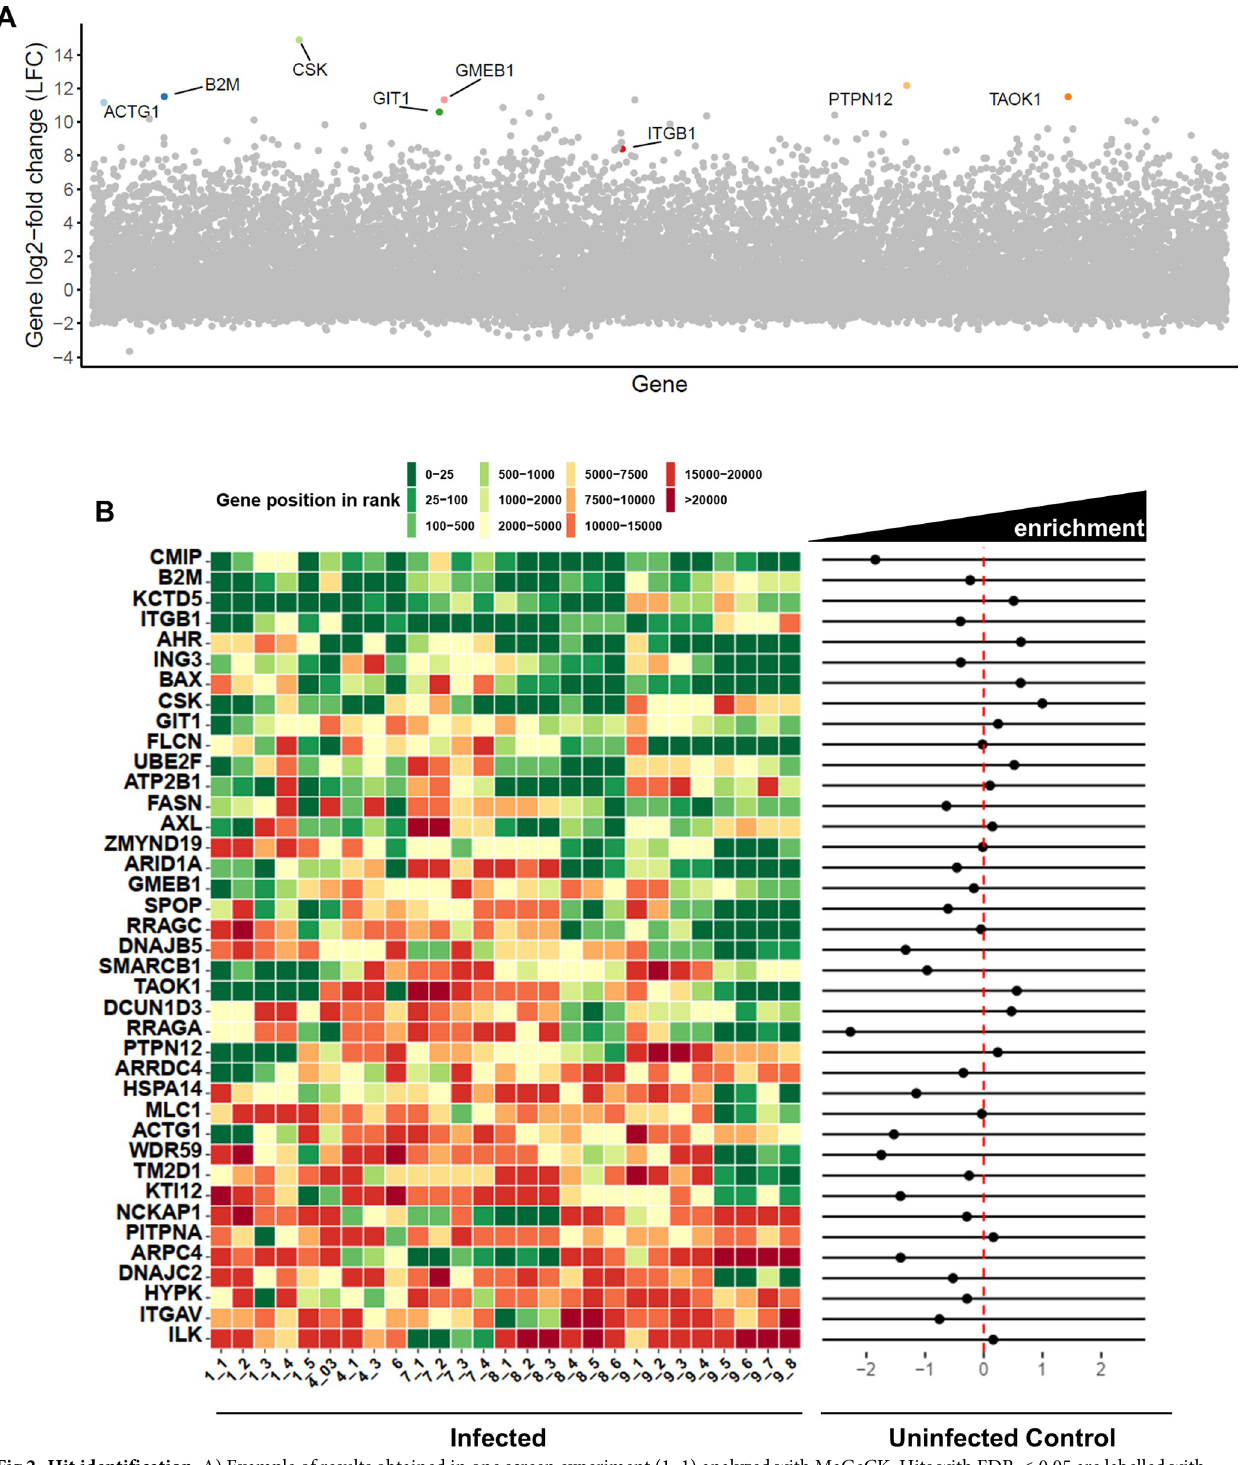
Fig 2. Hit identification. A) Example of results obtained in one screen experiment (1_1) analyzed with MaGeCK. Hits with FDR < 0.05 are labelled with gene name tags. B) Heatmap summarizing the 27 experiments/experiment variations. Experiments are named with the starting cell pool followed by a number for the conditions used for that particular sample (see S1 Table). Genes with FDR < 0.05 in at least 1 experiment are included in the analysis. Enrichment results after selection are shown in the left panel as a heatmap representing the gene rank obtained with MaGeCK. For comparison, the right panel shows the log2-fold change for each gene in non-infected control experiment. Dots to the right of the red dotted line indicate enrichment in non-